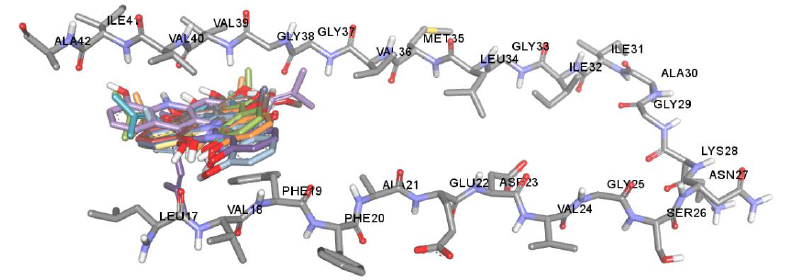
Figure 5. Superposition of docked orientations of all acridones on amyloid beta (PDB code: 2BEG).